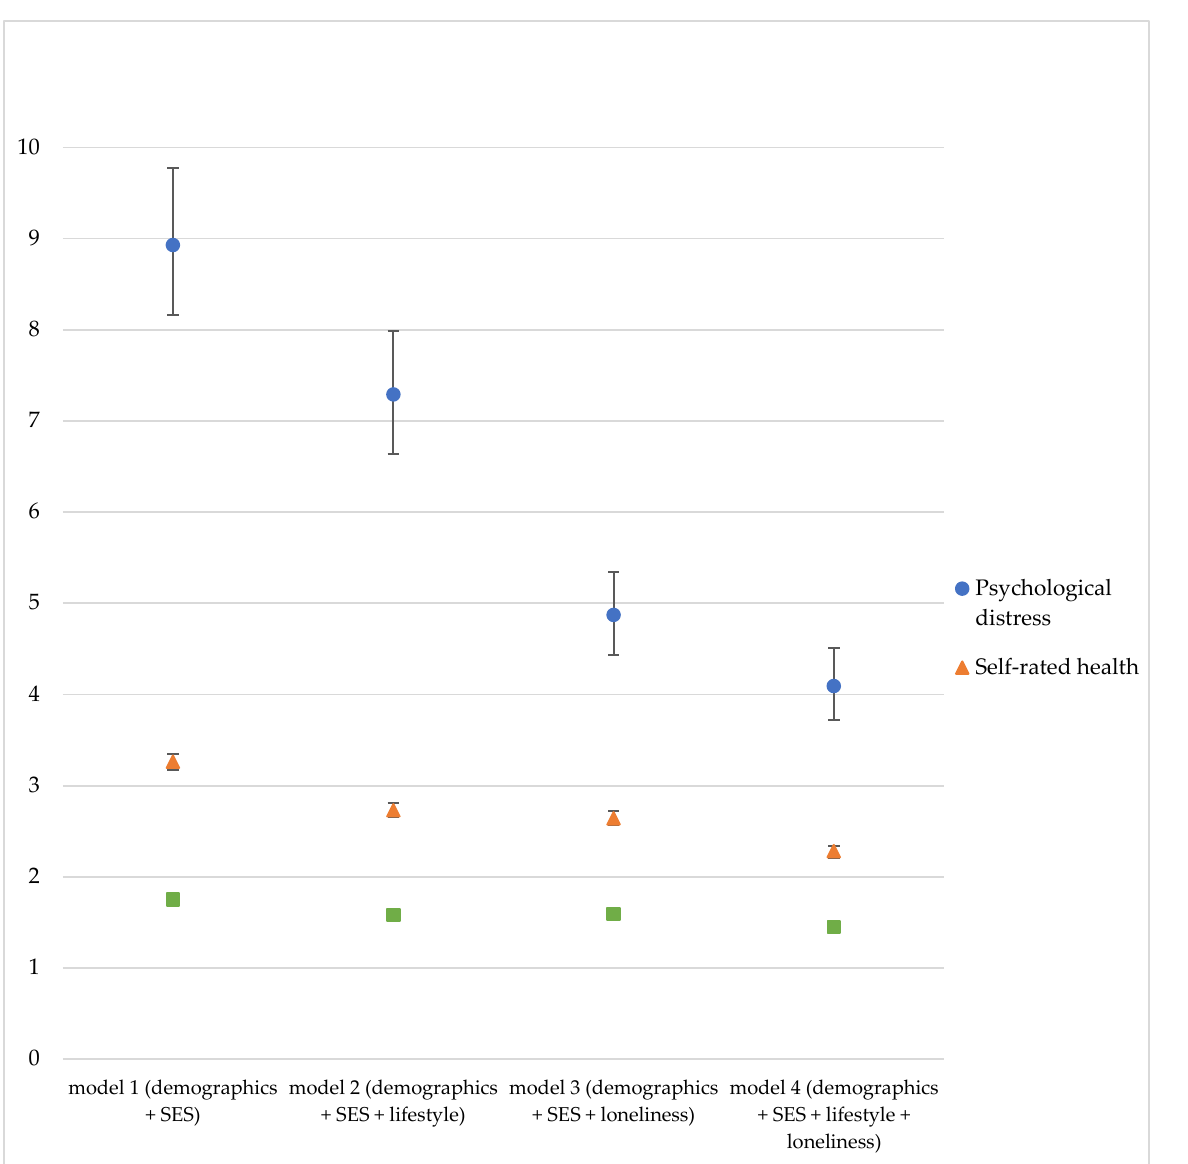
Figure 1. Odds ratios of having (1) high risk for psychological distress, (2) poor self-rated health, and (3) at least one chronic disease for individuals in the lowest SES group compared to the highest SES group. Figure 1 ORs (95% CI) (lowest SES group (Q1) vs. highest SES group (Q4)) in model 1 (demographic and SES factors), model 2 (demographic, SES factors, and loneliness), and model 3 (demographic, SES, lifestyle factors, and loneliness) for psychological distress (blue), self-rated health (orange), and chronic disease (green).